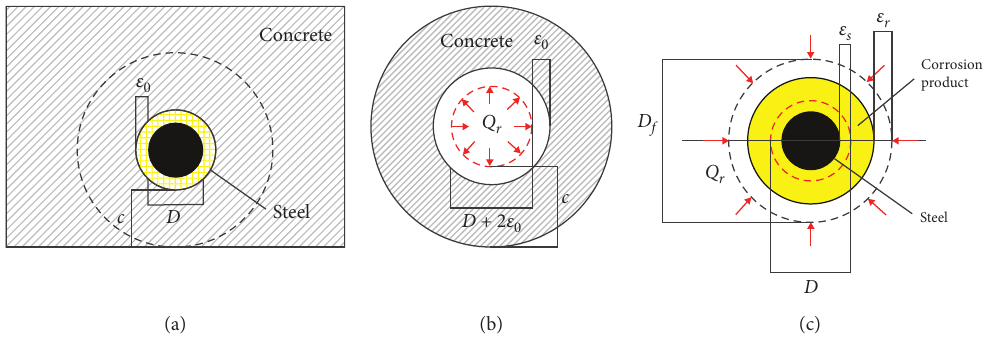
Figure 6: Thick-walled cylinder model. (a) Initial RC structure, (b) concrete deformation, and (c) deformation of corrosion products.